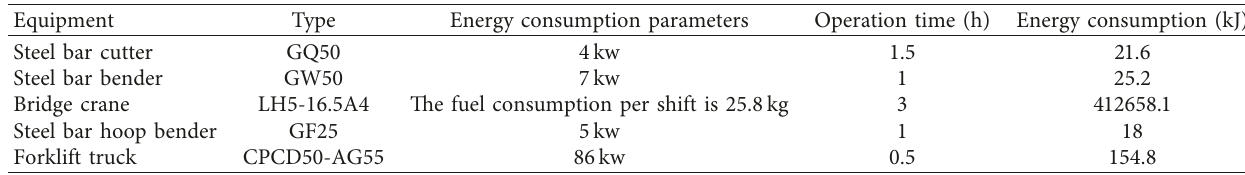
Table 10: Energy consumption data of each equipment for 1 m 3 prefabricated column production.